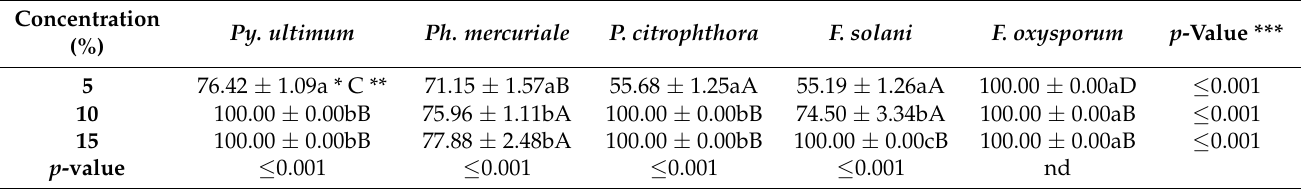
Table 1. Antifungal potential of three doses of Raphanus raphanistrum aqueous extract toward P. ultimum and P. mercuriale after 2 days and F. oxysporum , F. solani and P. citrophthora (Percent hyphal growth inhibition), noted after 6 days of incubation at 25 ◦